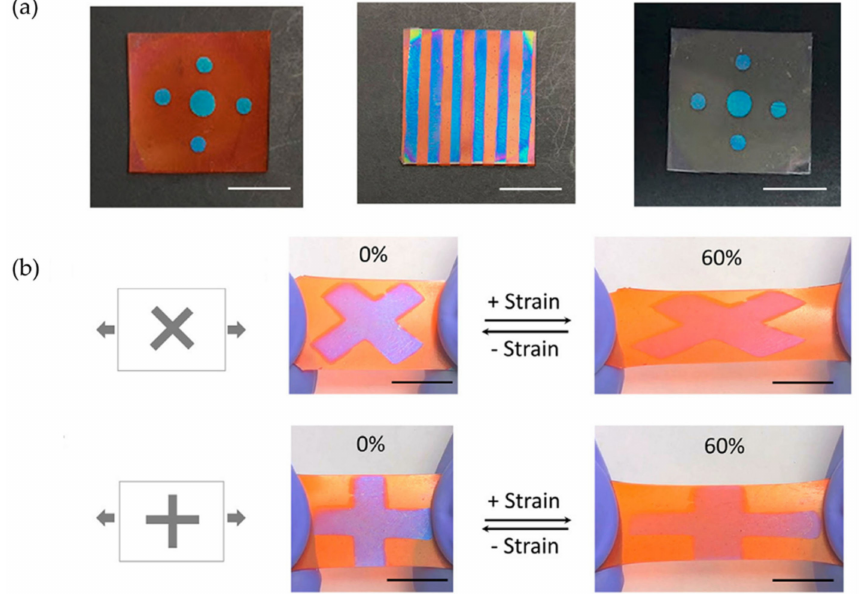
Figure 18. ( a ) Photographs of different color patterns generated in PVP-Ir-Dyed PDMS films with and without red dye and ( b ) stretching tests (from 0% to 60% strain) of the PVP-Ir-Dyed PDMS film, with load direction at 45 ◦ or 90 ◦ to the blue-colored cross pattern. Reproduced with permission